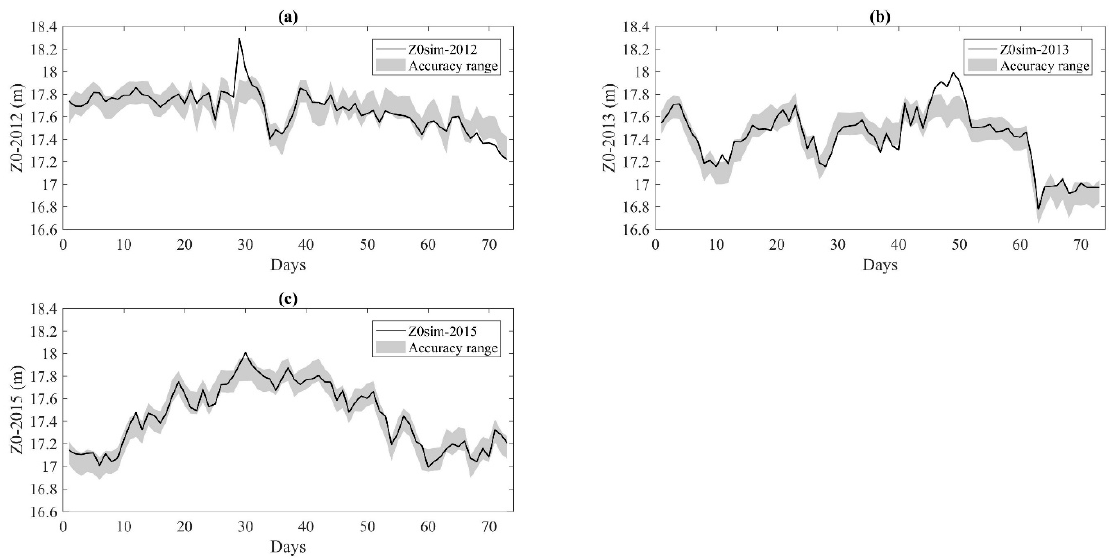
Figure 14. The linear interpolation of Z0 obs and Z0 sim for the optimized model for the years 2012 ( a ), 2013 ( b ) and 2015 ( c ). The results can be considered excellent for the years 2013 and 2015, with RMSE values of 0.09 m and 0.05 m, respectively. For 2012, especially the intercept of the linear interpolation (6.047) was significantly different from the optimal value (0). As already reported by Mesplé [83], the modelling overestimation/underestimation was probably combined with the proportionality of the gap between the measured and simulated values. Therefore, the RMSE for 2012 (0.09 m) was similar to the other years.